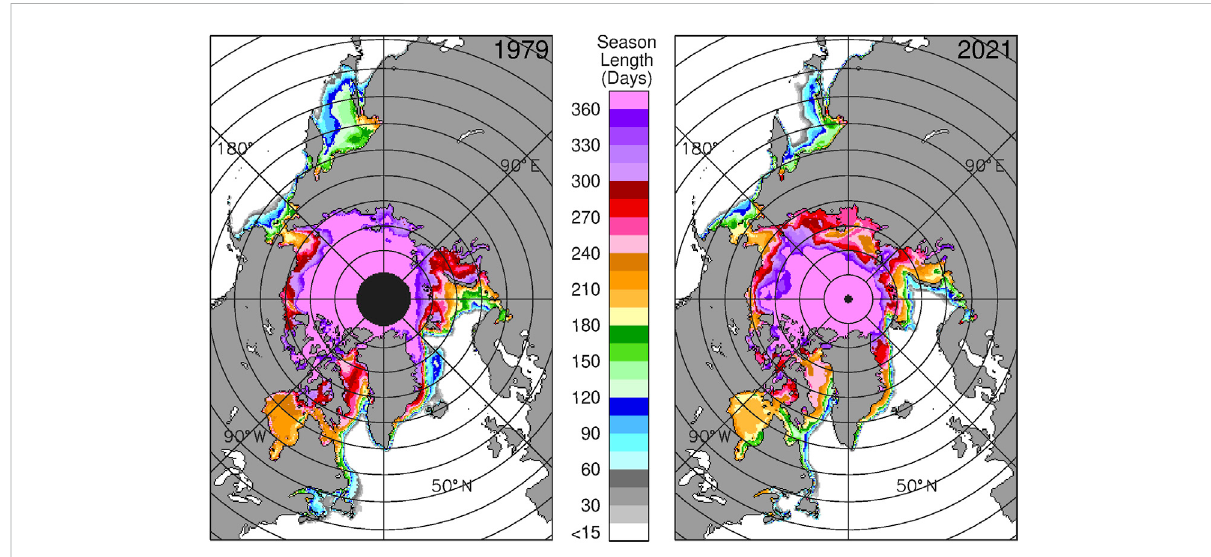
FIGURE 8 Length of the sea ice season in 1979 and 2021, as determined from satellite passive-microwave data by tallying, for each pixel, the number of days with calculated sea ice concentration at least 15%.